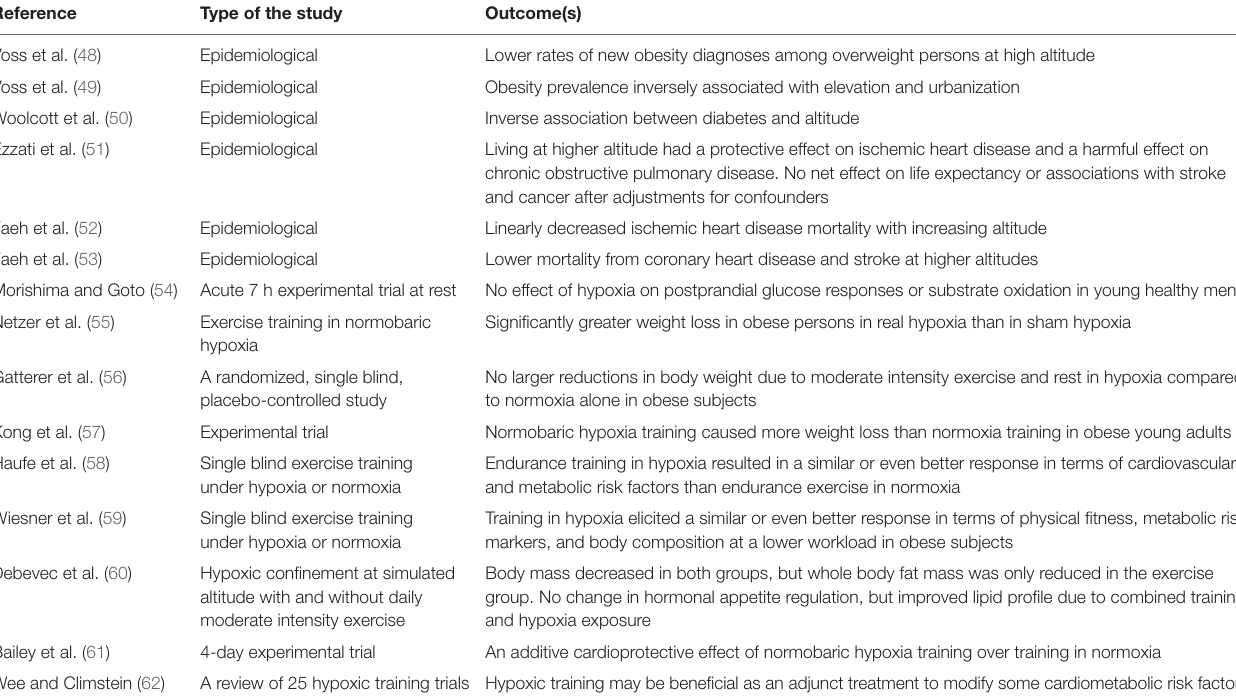
TABLe 1 | Summary of studies investigating the effects of hypoxia on cardiovascular and metabolic health in humans.